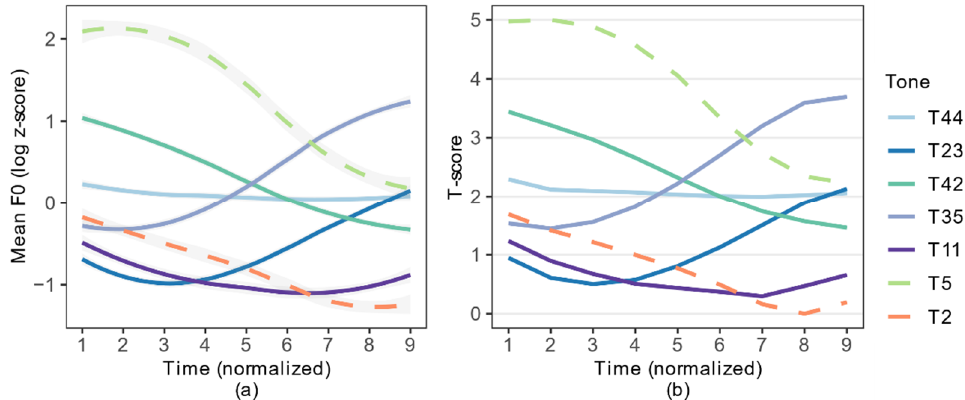
Table 6. T-score and Chao numeral conversion (Liu 2008).